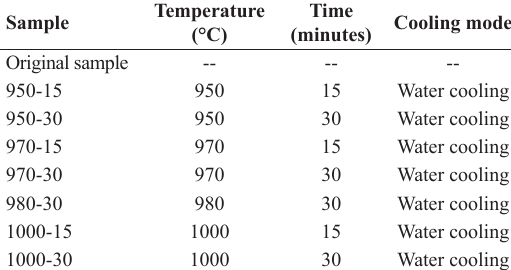
Table 1. The heat treatment conditions of Ti-5Nb-5Al alloy.